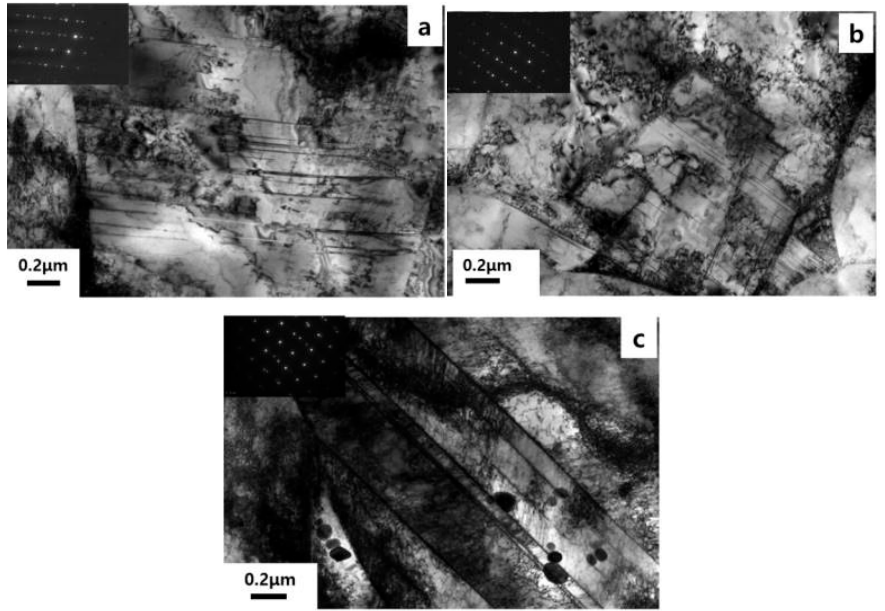
Figure 9. TEM microstructures of (NiCo) 75 Cr 17 Fe 8 ( a ), (NiCo) 75 Cr 17 Fe 8 C 0.34 ( b ) and (NiCo) 75 Cr 17 Fe 8 C 0.83 ( c ) deformed to 20% at cryogenic temperature.